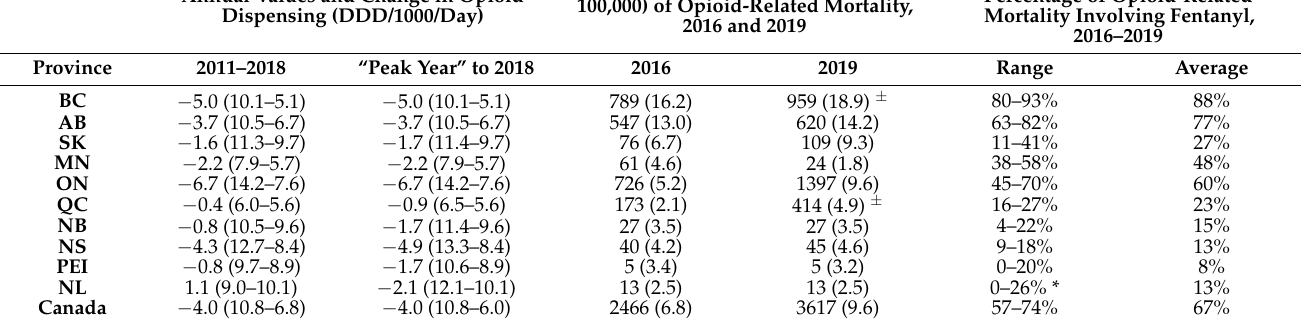
BC = British Columbia, AB = Alberta, SK = Saskatchewan, MN = Manitoba, ON = Ontario, QC = Quebec, NB = New Brunswick, NS = Nova Scotia, PEI = Prince Edward Island, NL = Newfoundland and Labrador. * data suppressed for 2016 and 2019. ± Includes deaths related to all illicit drugs including, but not limited to, opioids and